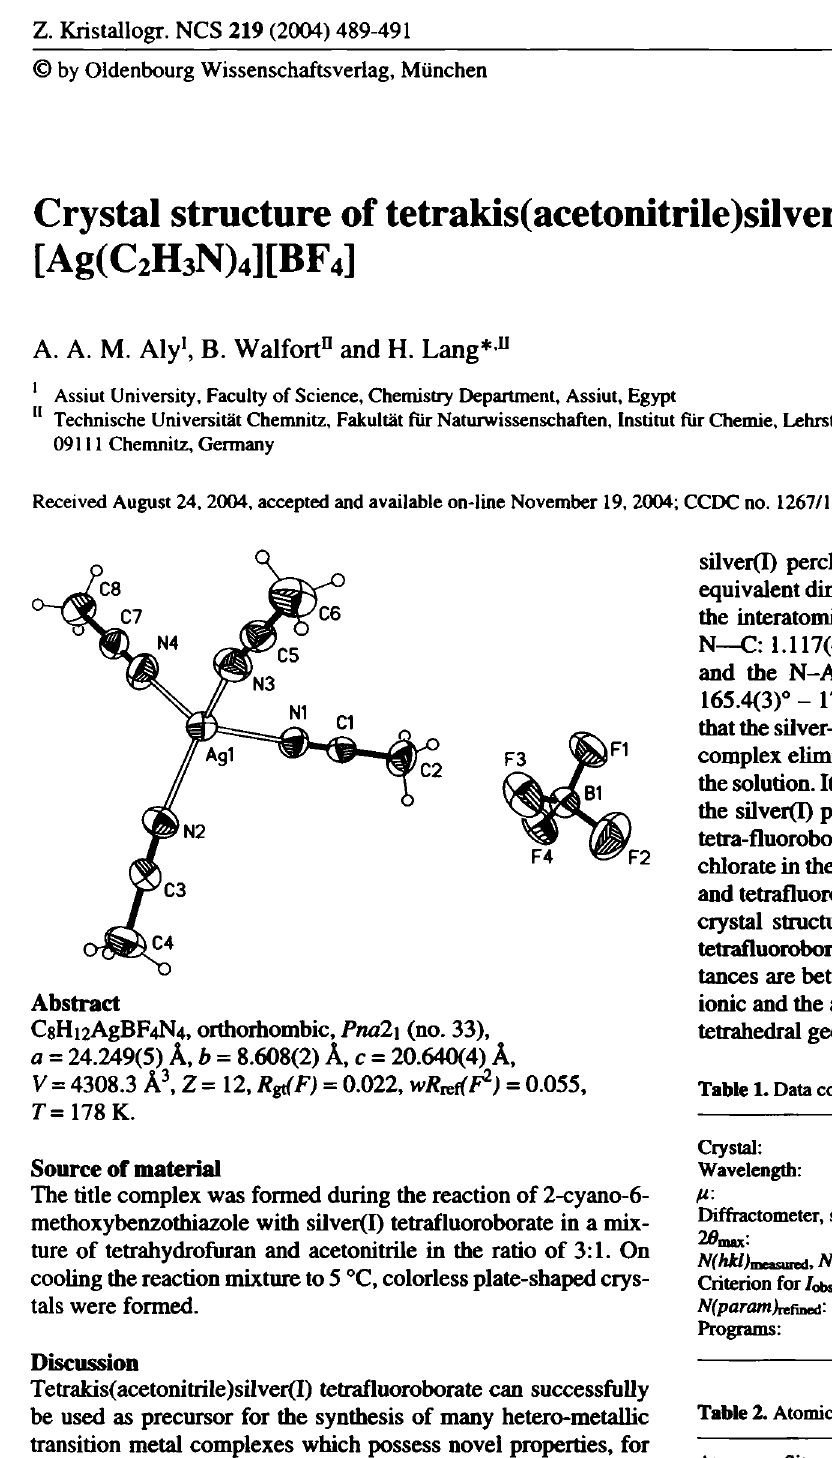
Table 2. Atomic coordinates and displacement parameters (in Á 2